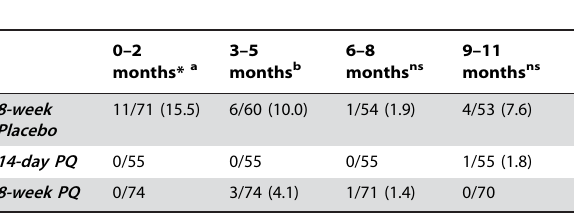
Table 5. Number (%) with treatment failure during different stages of follow-up over the 11 month observation period.